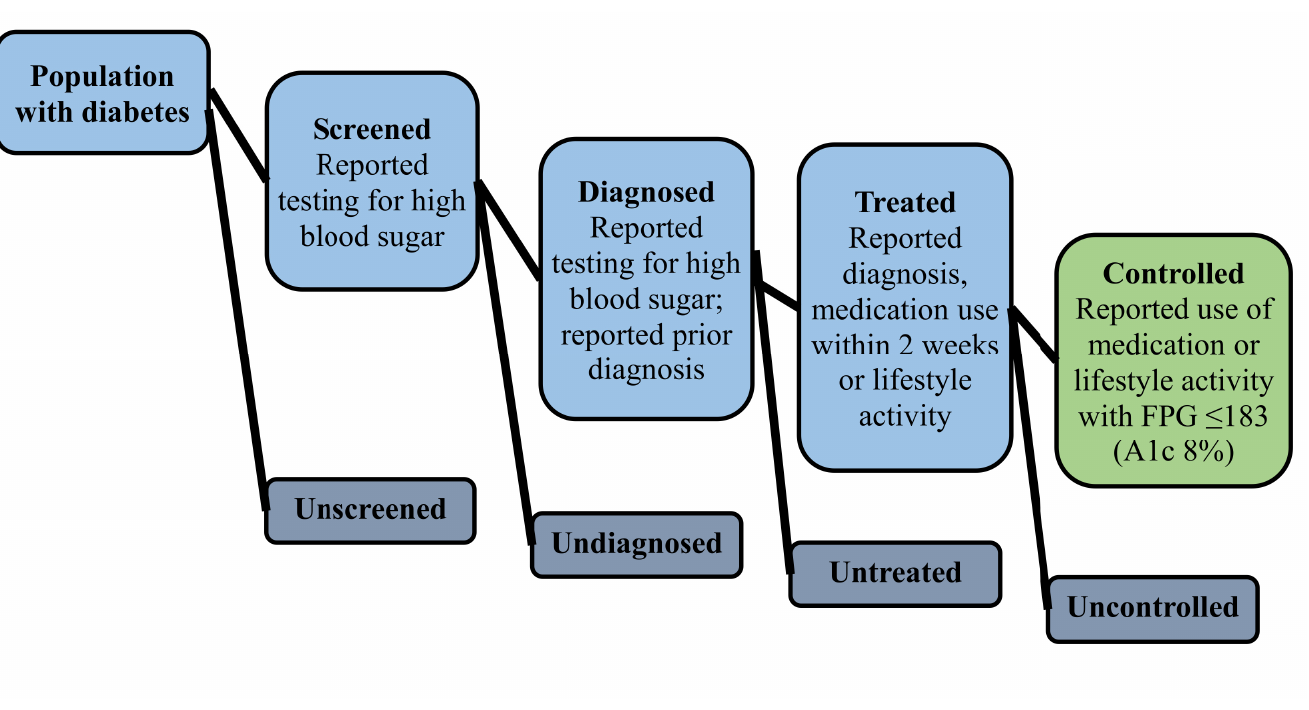
Fig 1. Diabetes care cascade